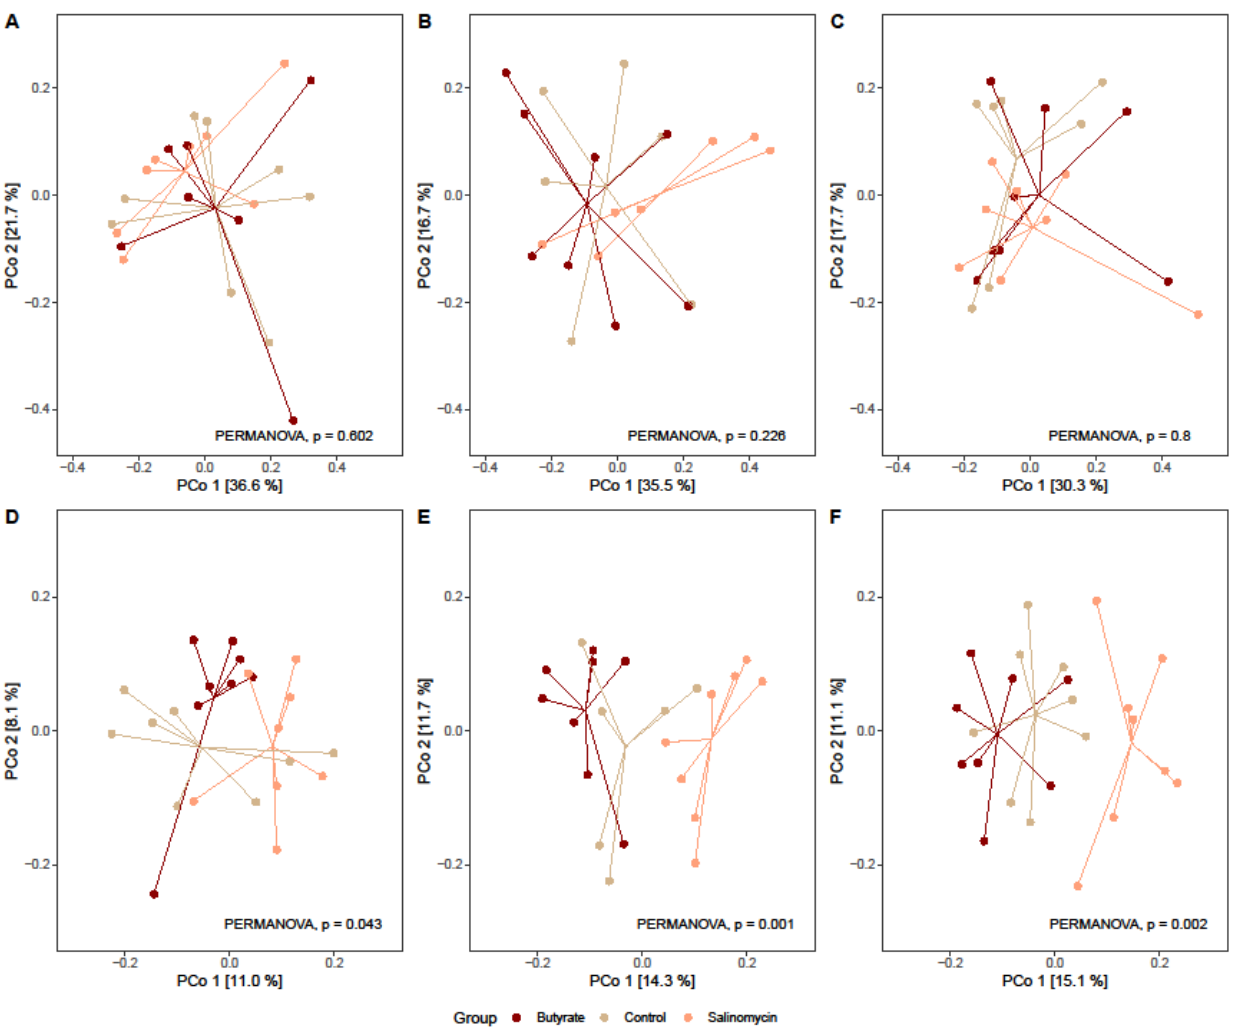
Figure 4. Treatment effect on beta diversity (Bray-Curtis distances) for ileum samples collected on days ( A ) 21, ( B ) 24, and ( C ) 29, and for ceca samples collected on days ( D ) 21, ( E ), 24, and ( F ) 29 of age from chickens administered butyrate (UltraGuard™-DUO, 500 mg/kg), salinomycin (Sacox ® , 69 mg/kg), or no dietary supplement (control). Overall differences in centroids (group means) were estimated by PERMANOVA, and p values are provided.